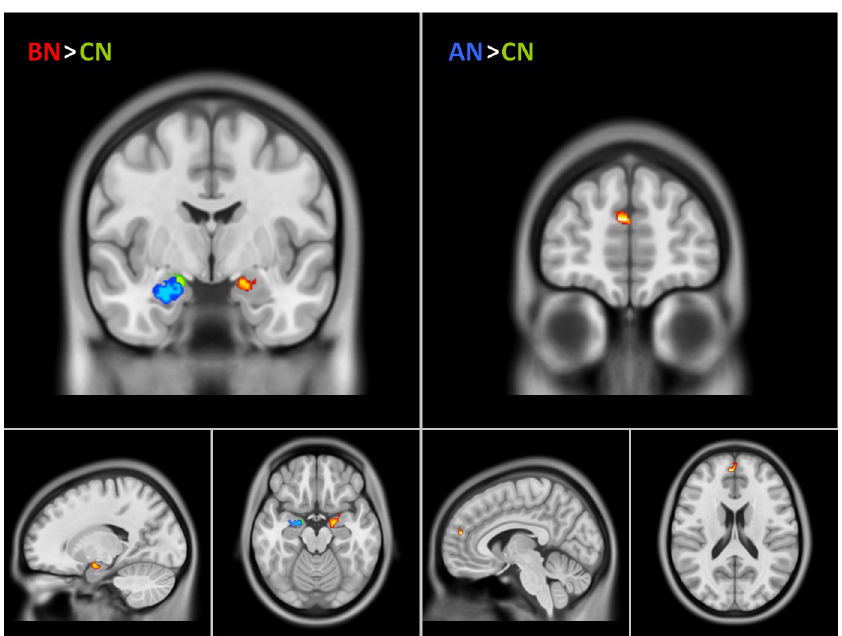
Fig 5. Second-level analysis MVPA group differences. Second-level analysis using the SVM weights, performed as a one-way ANOVA (factor: GROUP. AN = Anorexia Nervosa, BN = Bulimia Nervosa, CN = Normal Controls). Two clusters were more important for decoding the different emotions and the neutral conditions: right centromedial amygdala for BN and MPFC for AN (compared to CN). In light green and blue we show the centromedial and the basolateral portions of the amygdala according to the Pauli atlas [53]. Clusters depicted on orthogonal projection of an ICBM-152 brain template in neurological convention (p < .05 FWEc).